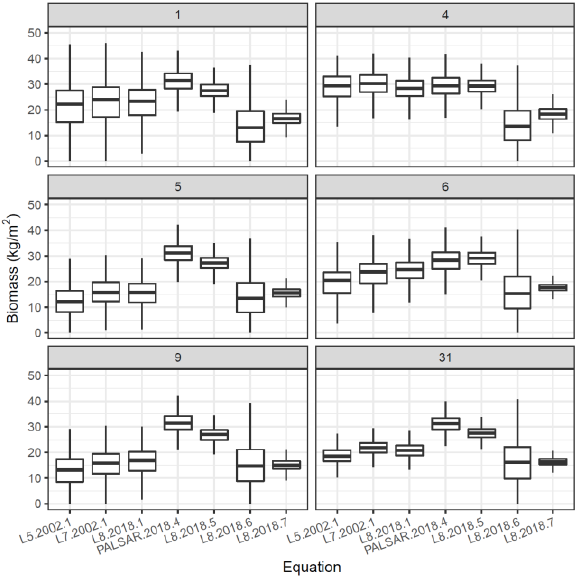
Figure 8. Aggregated statistics for six